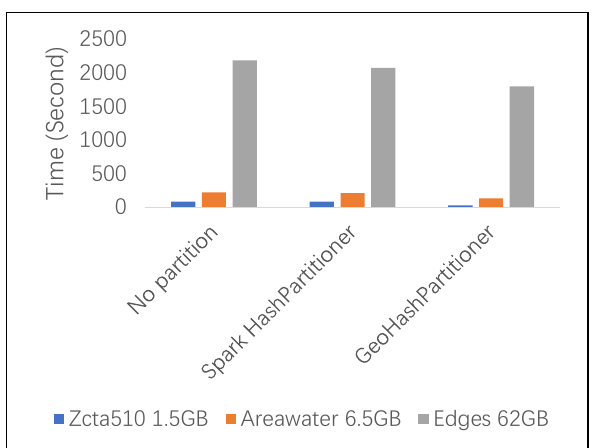
Figure 4. Range query experiments with different partition and data size